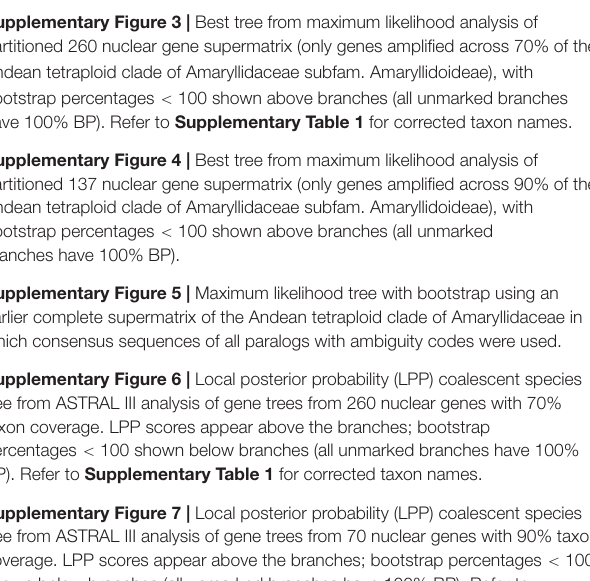
Amaryllidoideae.